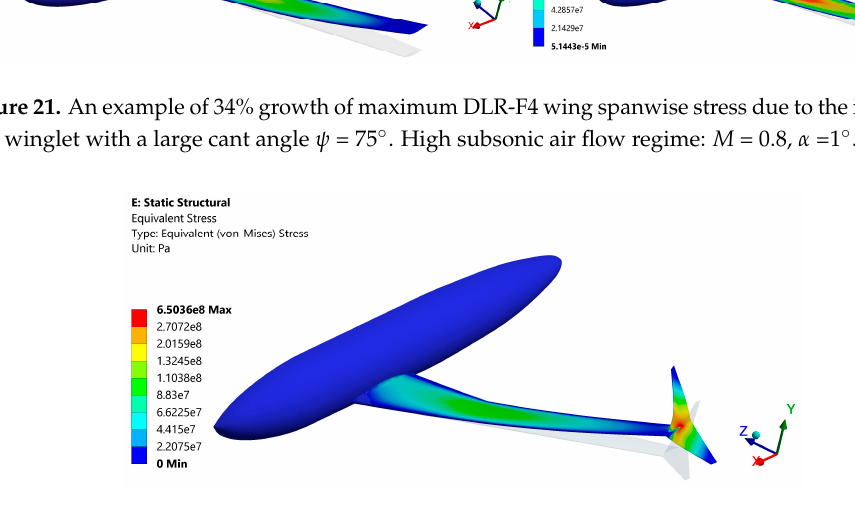
Figure 22. Distribution of wing spanwise stress after the installation of a ‘flat’ delta planform wingtip fence: despite low-stressed wingspan, significant local stress and deformations can be observed on the wingtip fence itself and its junction area. Air flow regime—high subsonic: М = 0.8, α = 1°.